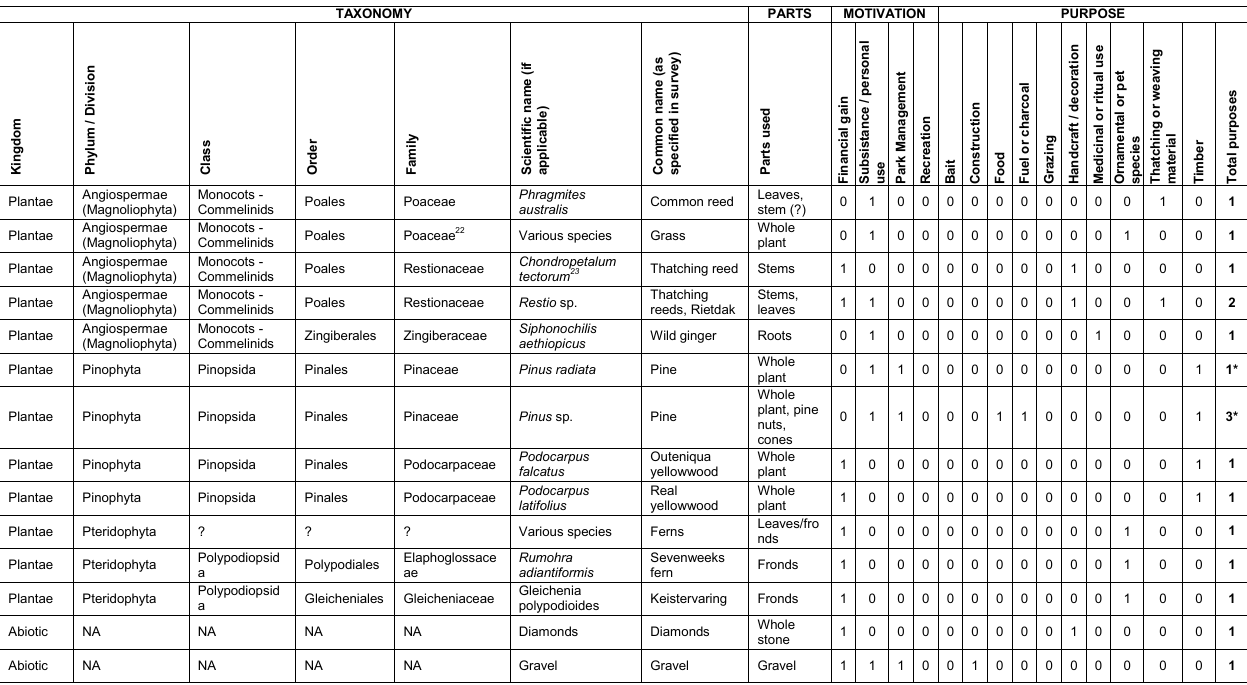
Gleicheniales Gleicheniaceae Gleichenia